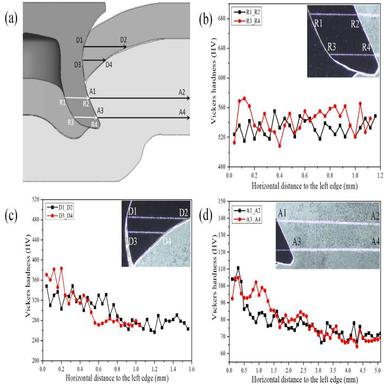
Engineering stress–strain curves at different pre-strain levels for (a) AC43500-T7 and (b) DP590.